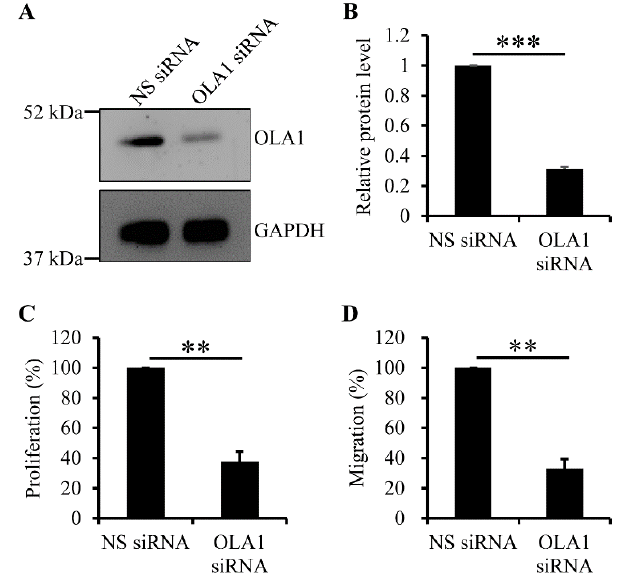
Figure 3. Effect of OLA1 RNAi (RNA interference) on proliferation and migration of human aortic SMCs. ( A , B ) Depletion of OLA1 in human aortic SMCs. After human aortic SMCs were transfected with non-silencing (NS) or OLA1 siRNA duplexes for 42 h, cells were collected and lysed for immunoblot analysis with antibodies against OLA1 and GAPDH (loading control). Immunoblot images of both OLA1 and GAPDH are shown in ( A ). The band intensities of OLA1 and GAPDH from ( A ) were determined using LS software from VisionWorks (UVP, LLC). The band intensity of OLA1 was normalized to that of GAPDH, and the relative protein levels of OLA1 normalized to the non- silencing treatment in the graph shown in ( B ) are the means ± s.d. (error bars) from three independent experiments. ***, p < 5 × 10 − 7 . ( C ) Depletion of OLA1 causes a reduced proliferation of human aortic SMCs. After human aortic SMCs were transfected with the indicated siRNA duplexes for 42 h, 1.5 × 10 4 cells were incubated with the BrdU-containing medium for 8 h. The BrdU-incorporated cells were stained using 3,3 (cid:48) -diaminobenzidine tetrahydrochloride for analysis (see the Materials and Methods section (Section 4.8)). Each independent experiment was quadruplicated. In the graphs, values are the relative percentages of the amounts of incorporated BrdU in cells normalized to the non-silencing treatment and the means ± s.d. (error bars) from three independent experiments. ***, p < 5 × 10 − 4 (Student’s t -test). ( D ) Depletion of OLA1 causes reduced migration ability in human aortic SMCs. After human aortic SMCs were transfected with the indicated siRNA duplexes for 42 h, 3 × 10 4 cells were resuspended in 100 µ L of 0.5% FBS medium for the trans-well assay (see the Materials and Methods section (Section 4.8)). The cells stuck in the pores of the filter were imaged and quantitated. Each independent experiment was triplicated. In the graphs, values are the relative percentages of migrating cells normalized to the non-silencing treatment and the means ± s.d. (error bars) from three independent experiments. **, p < 5 × 10 − 5 (Student’s t